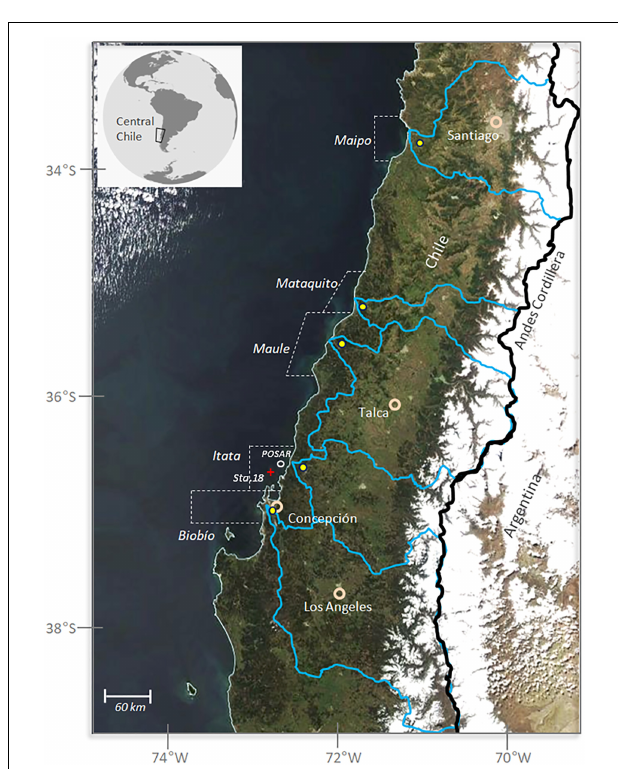
FIGURE 1 | General map of the study area. The background picture is a TERRA-MODIS visible image (September 22, 2013) upon, which we have mapped the main river basin boundaries (blue lines) and the Chile-Argentina border (black line following the Andes crest level). Off Itata River we have mapped the position of the Oceanographic Station 18 and the coastal buoy POSAR. Also shown are coastal adjacent areas at the mouth of each river (dashed polygons) and major